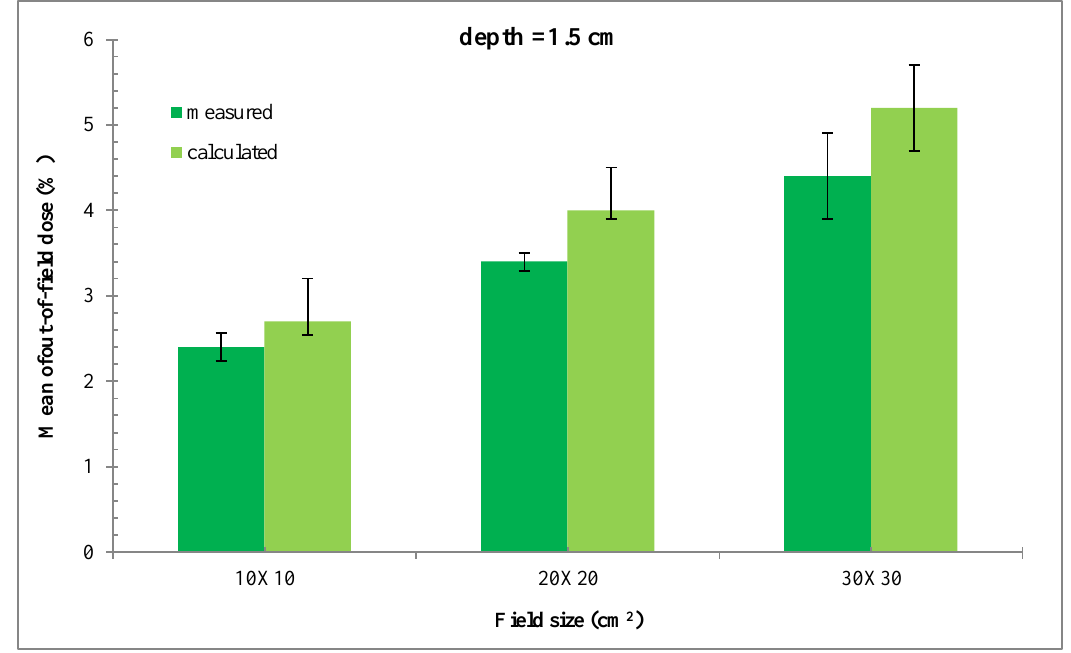
Figure 5.Variation of measured and calculated mean out-of-field dose with field size using Markus ionization chamber detector. The error bars represent the standard deviation